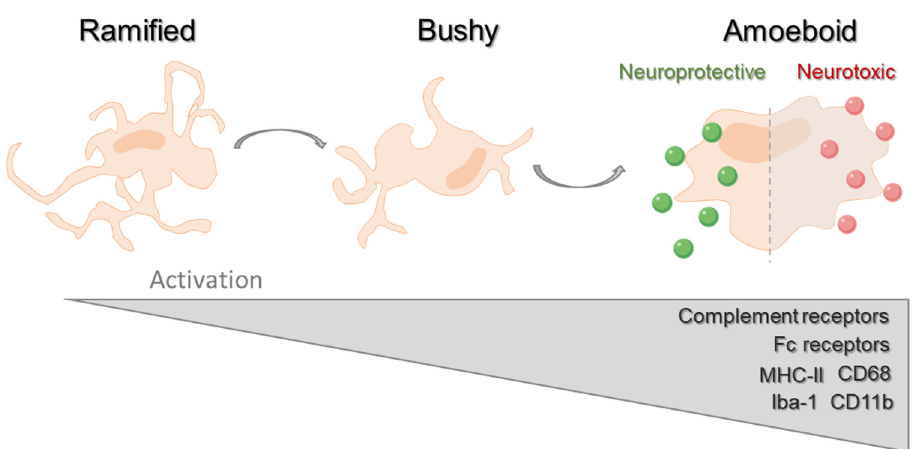
Figure 1. Schematic representation of microglial activation. Following any insult or alteration in brain homeostasis microglia become activated. Morphologically, cells partially retract their processes evolving from a ramified state, to an intermediate one or “bushy” and finally converting into a complete rod and amoeboid shape or fully activated state. In parallel, activated microglia overexpress specific characteristic markers such as ionized calcium-binding adaptor molecule-1 (Iba-1), major histocompatibility complex antigen class II (MHC-II), and microglial phagocytic markers such as CD11b, complement and Fc receptors I–III, and CD68. Finally, these activated cells can evolve into functionally distinct phenotypes either becoming neurotoxic or neuroprotective-reactive states associated with the release of both pro- and anti-inflammatory mediators and cytokines, respectively.